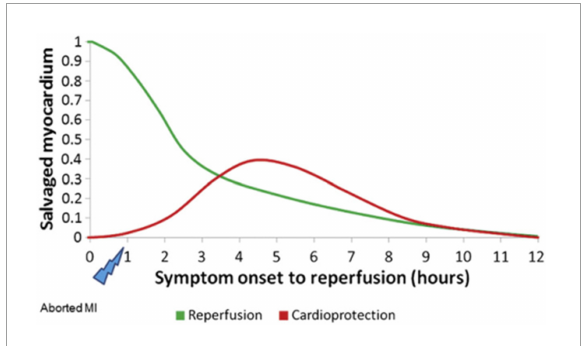
FIGURE2 Hypothetical temporal relationship between reperfusion and cardioprotection in STEMI [Adapted from Bainey and Armstrong